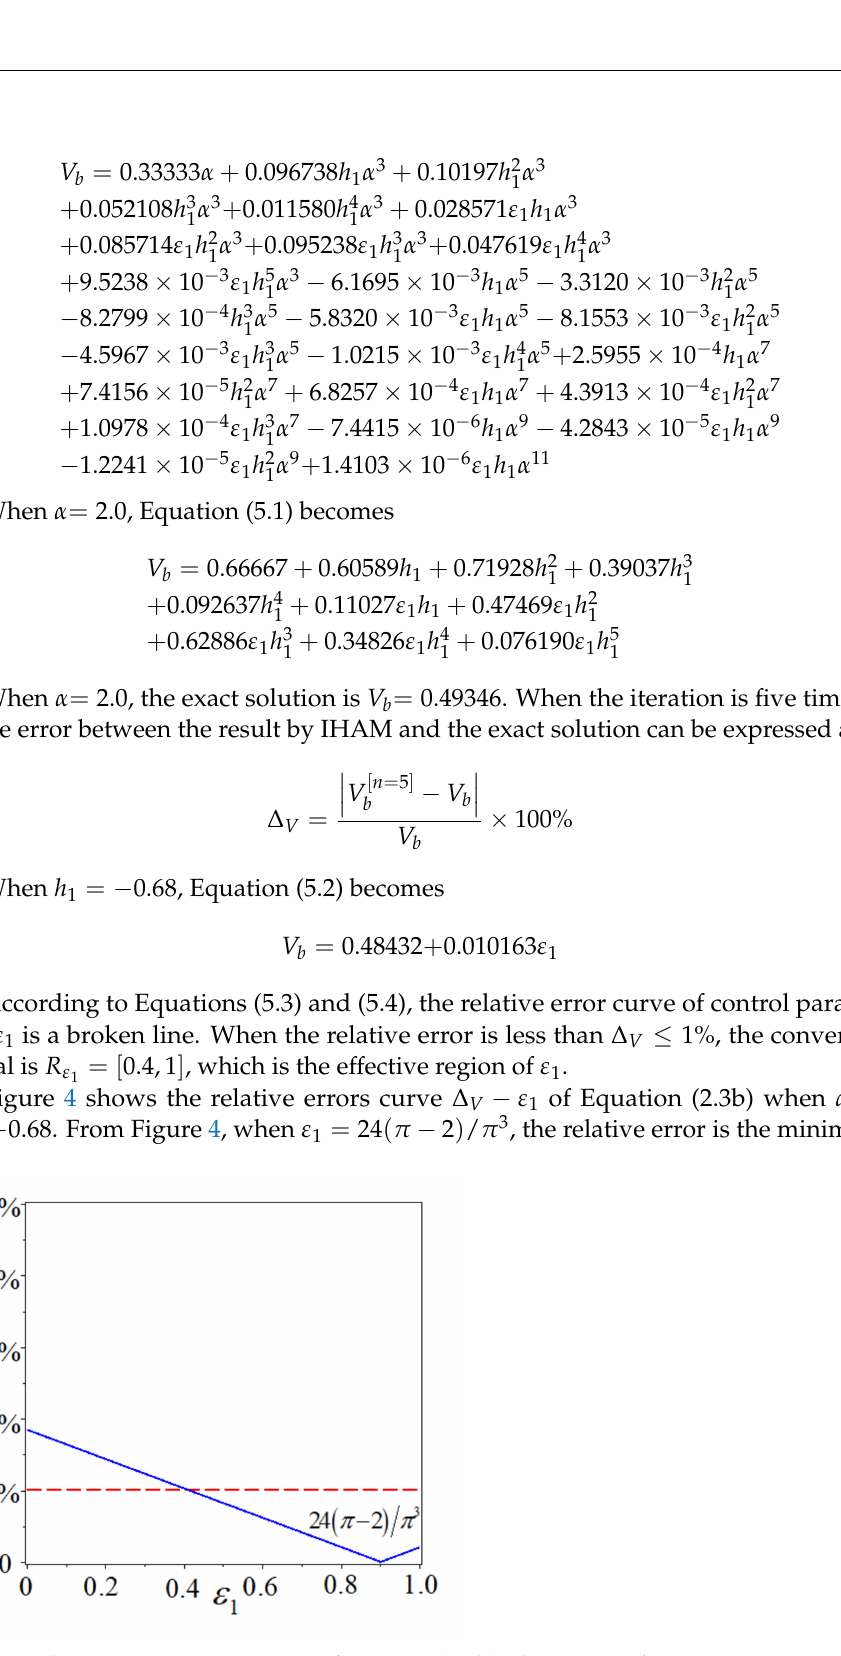
Figure 4. Relative errors curve ∆ V − ε 1 of Equation (2.3b) when α = 2.0, h 1 = −